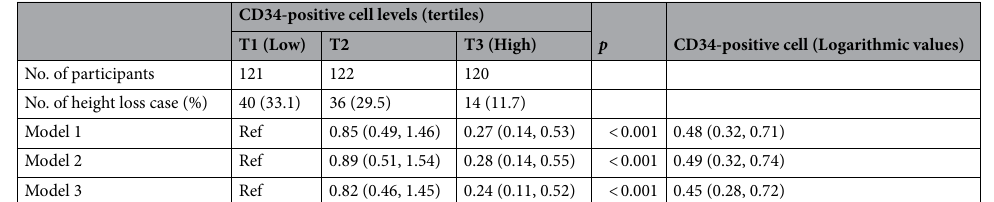
Table 2. Association between height loss and circulating CD34-positive cell. Ref: reference. Model 1, adjusted only for age. Model 2, adjusted further for age plus body mass index (BMI), systolic blood pressure (SBP), alcohol consumption (never-, former-, current- [23–45 g/week, 46–68 g/week, 68 g/week <], smoking status (never-, former-, current), HDL-cholesterol (HDLc), triglycerides, glycated hemoglobin (HbA1c), and estimate glomerular filtration rate (eGFR). Model 3, adjusted only for age, hematological parameters (white blood cell count, platelet count, and hemoglobin), and height at baseline. CD34-positive cell count tertiles were T1 (Low), < 0.78 cells/μL; T2, 0.78–1.31 cells/μL, and T3 (High), ≥ 1.32